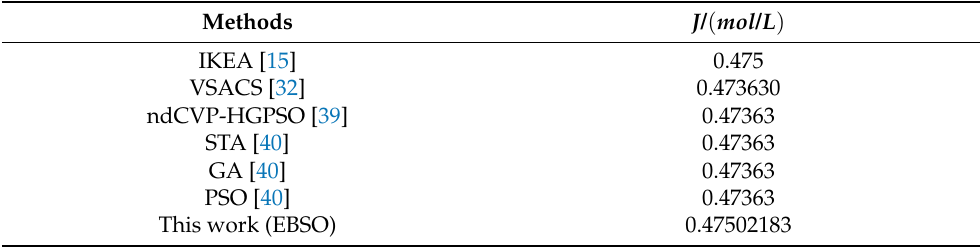
Table 8. Comparison of methods of tubular reactor ( N =